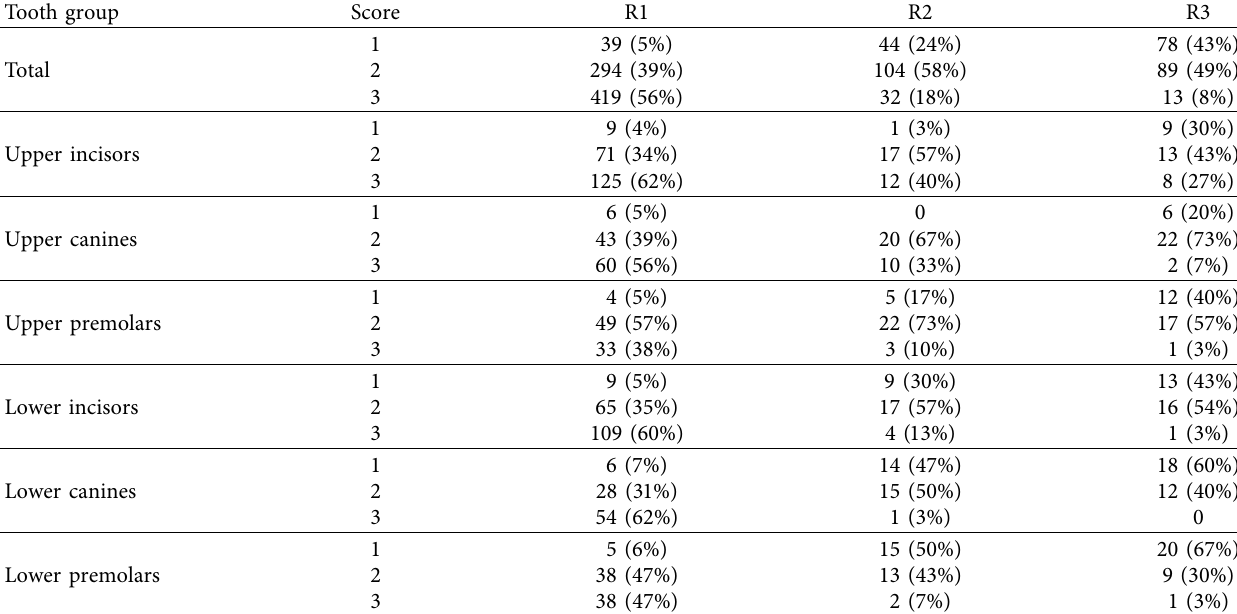
Table 8: Image quality scores by raters and groups. Number of images with each score and percentage from the total.